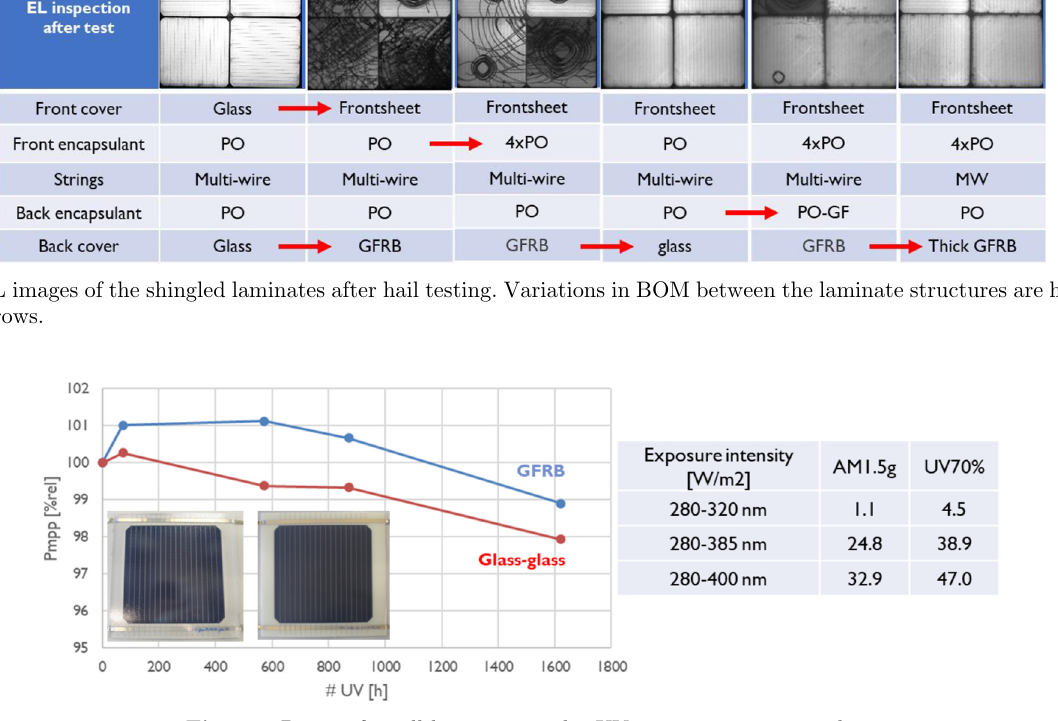
Fig. 13. Pmpp of 1-cell laminates under UV exposure up to 1600 h.